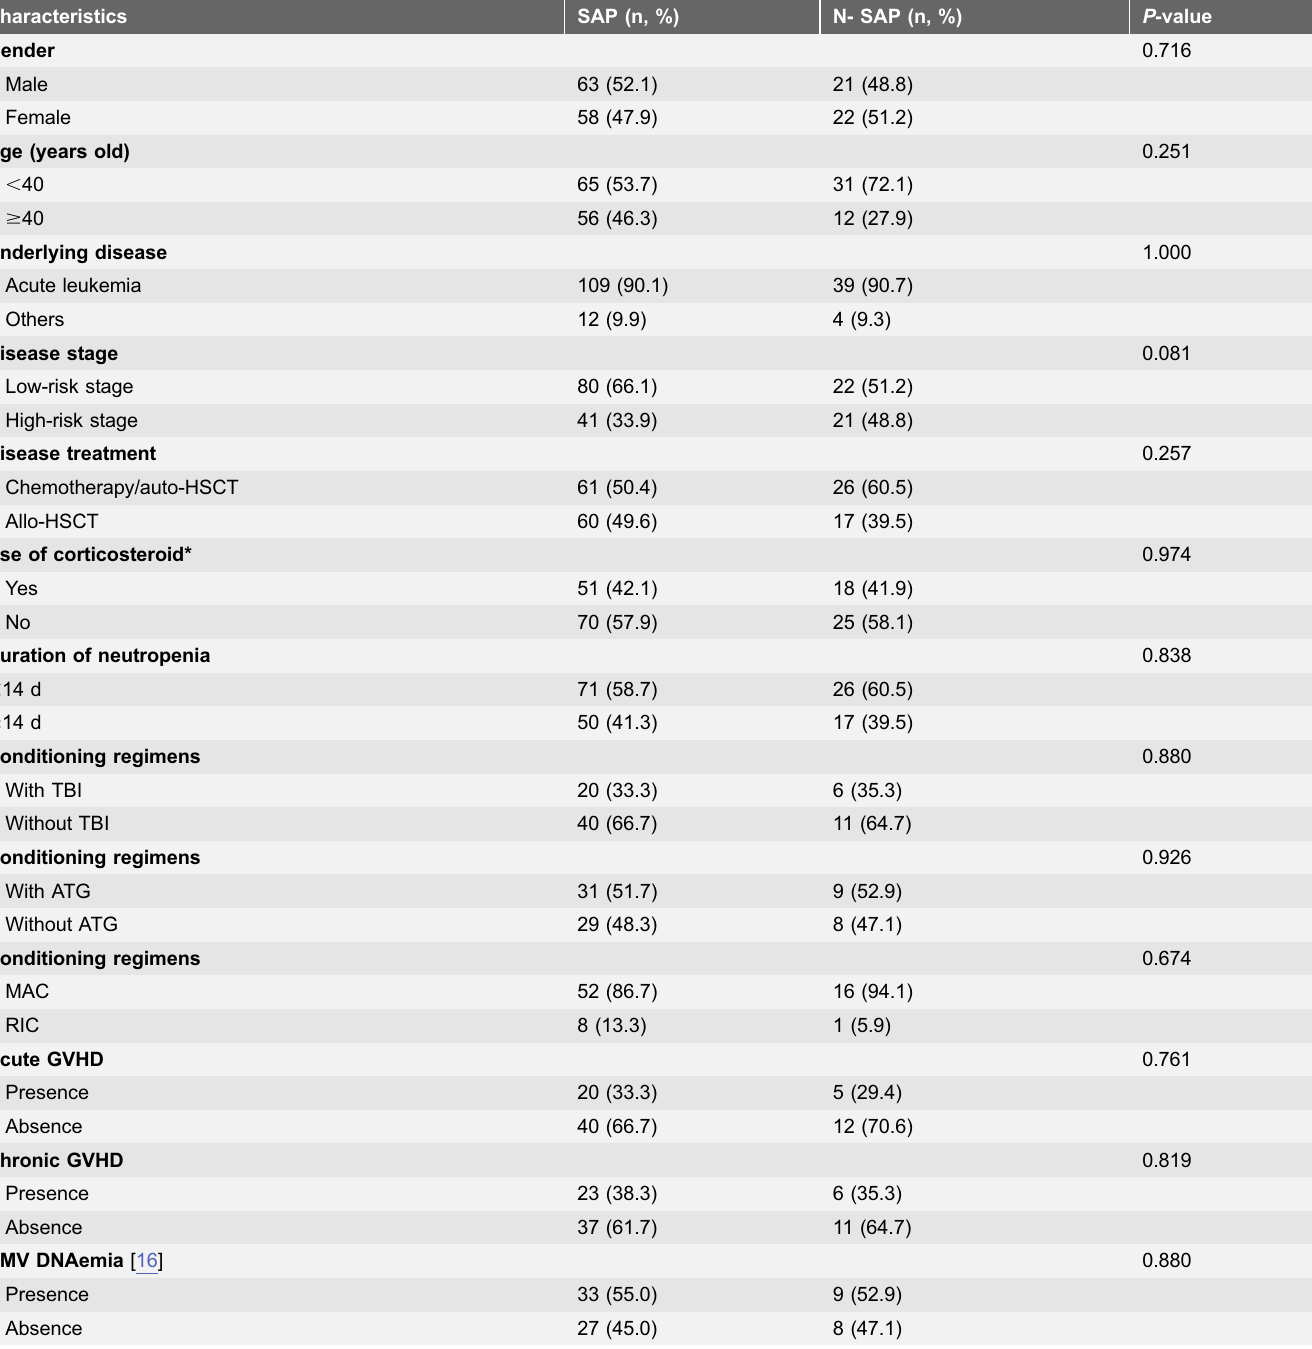
Table 2. Characteristics of patients in SAP group and non-SAP